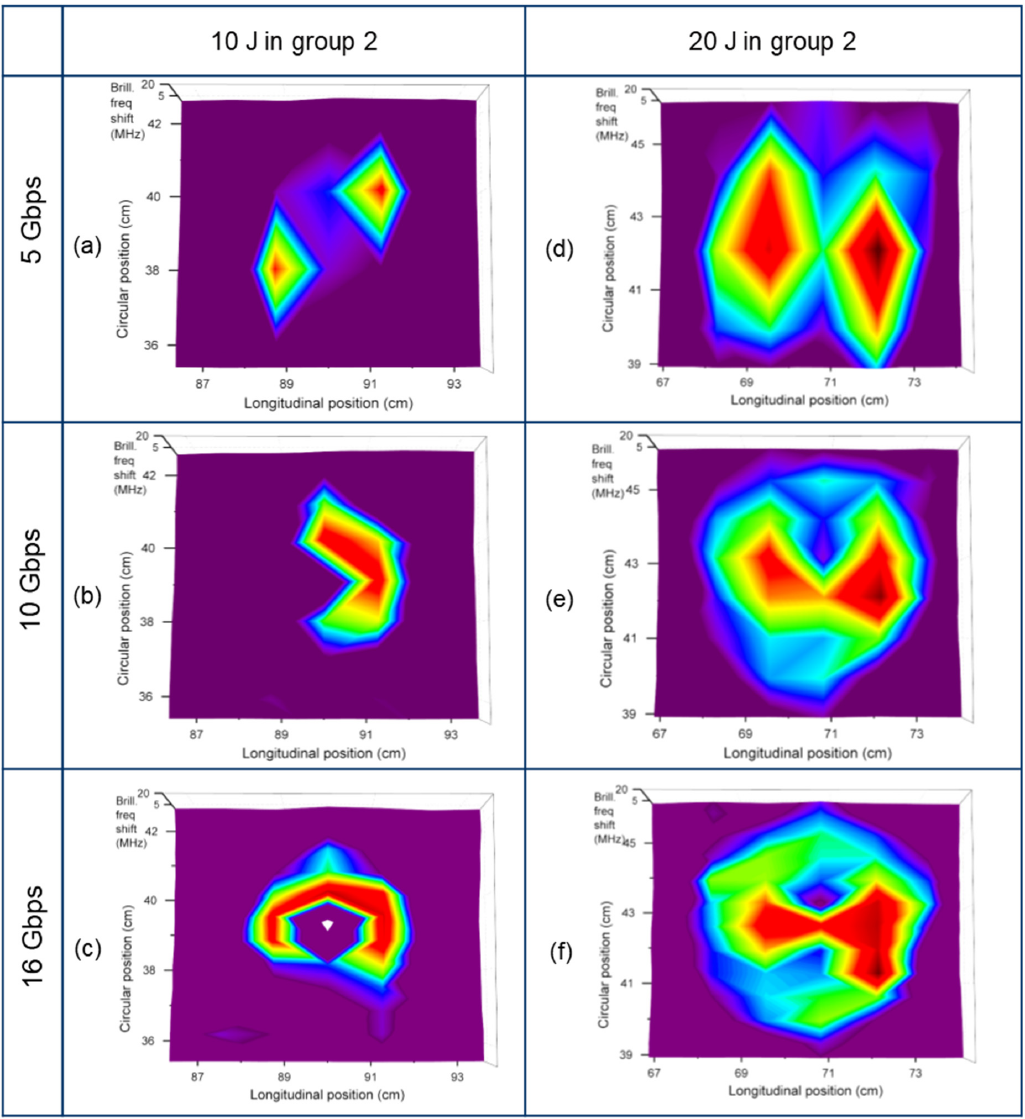
Figure 7. Damage map comparison for ( a – c ) 10 and ( d – f ) 20 J impacts according to the modulation rates of 5, 10, and 16 Gbps.